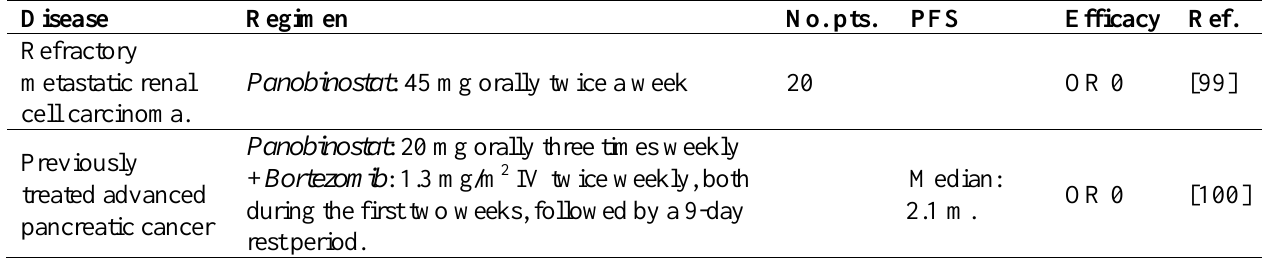
Table 5. Panobinostat in published phase II clinical trials in solid